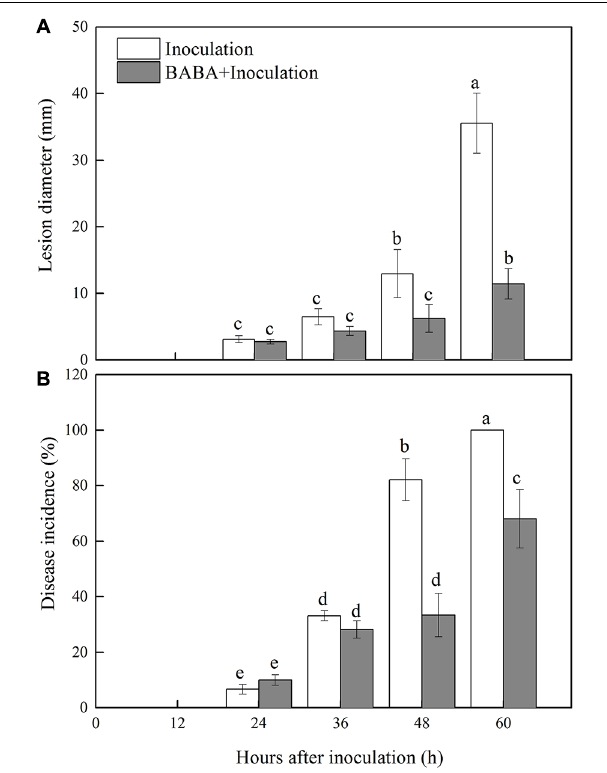
FIGURE 1 | Changes in lesion diameter (A) and disease incidence (B) in peach fruit inoculated with Rhizopus stolonifer (Inoculation) or pretreated with 50 mM BABA and then inoculated with R. stolonifer (BABA + Inoculation) during storage at 20 ◦ C. Each column represents the mean of triplicate samples. Vertical bars represent the standard errors of the means. Letters without the same letter above the bars indicate significant differences at P < 0.05.